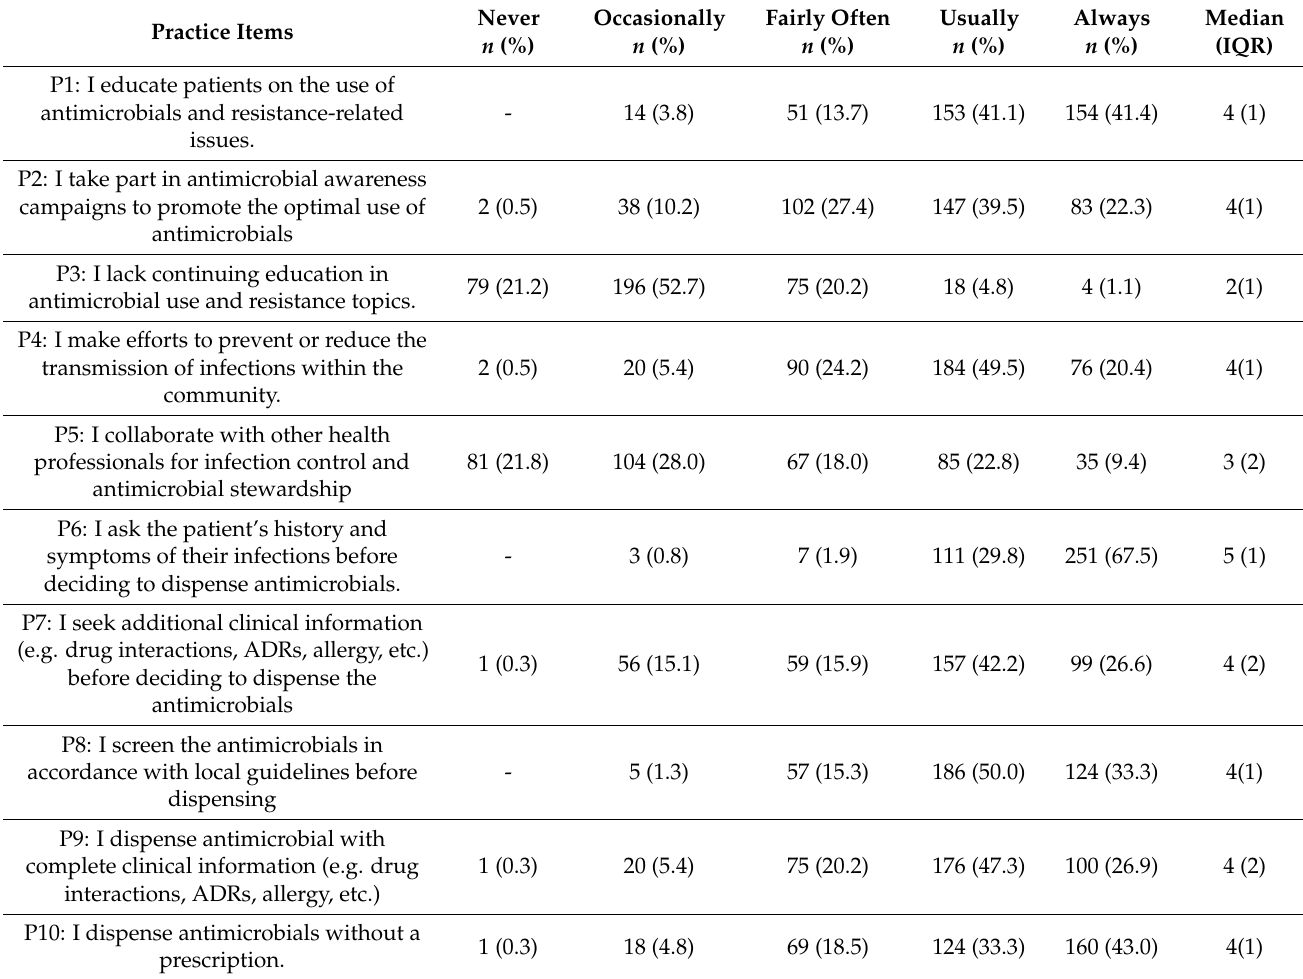
Table 4. Community pharmacists’ practices relating to antimicrobials’ use and resistance.